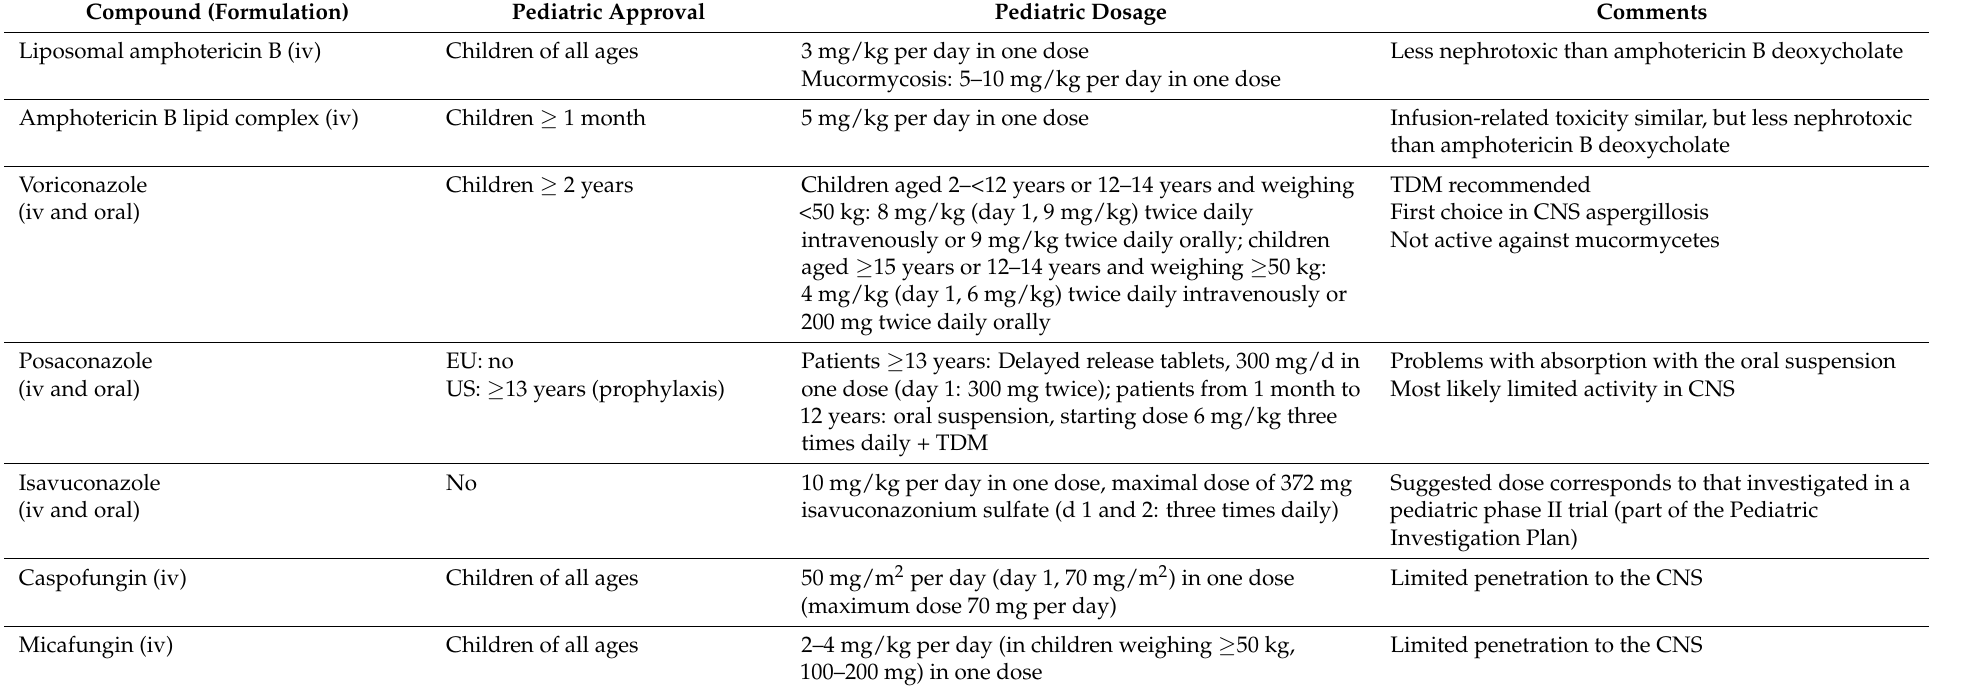
Table 1. Antifungal agents for potential use in invasive mold disease of the central nervous system